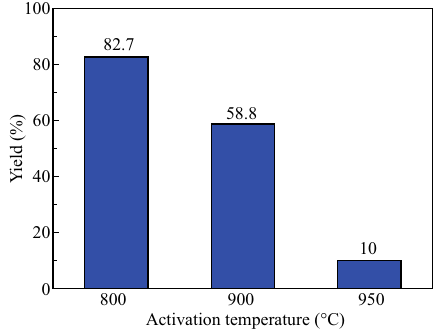
Fig. 2 Yield of the activated samples prepared by the activation of NHCSs with CO 2 at different temperatures. Yield (%) = the ratio of the mass of the activated product divided by the mass of the original weight of NHCSs 9